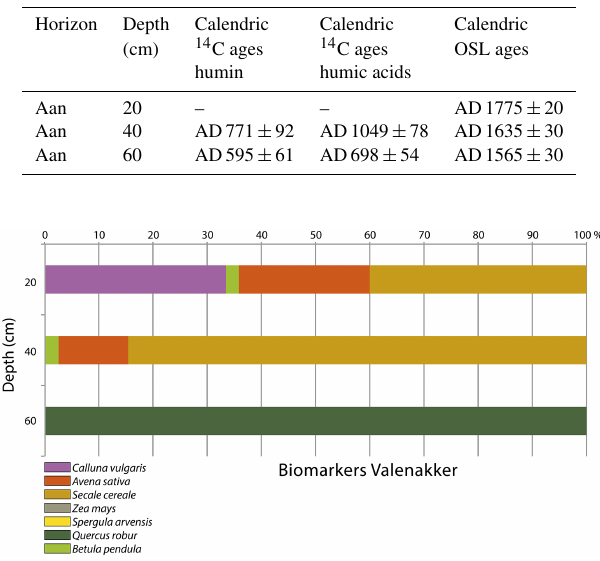
Figure 9. Biomarker diagram Valenakker.